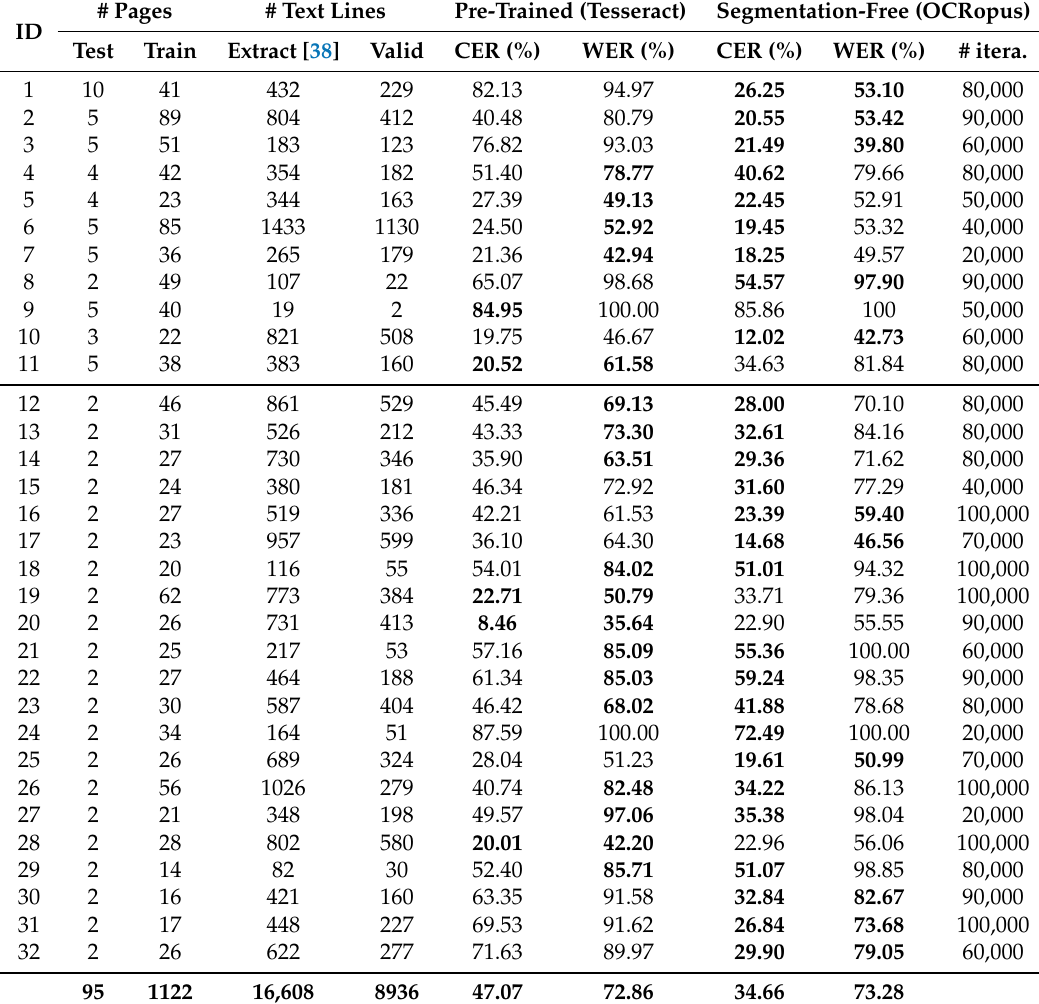
Table 12. Pre-trained and segmentation-free OCR results on eBDtheque (Albums 1–11) and DCM772 (Albums 12–32) datasets. The first five columns show the album ID, the number of pages for the testing and training sets, and the number of text lines that have been extracted and validated, respectively. The next four columns indicate the average Character Error Rate (CER) and Word Error Rate (WER) of both OCR systems. The last column shows the number of iterations of the trained LSTM model that gives the lowest CER. The last row indicates the total or average of the values mentioned